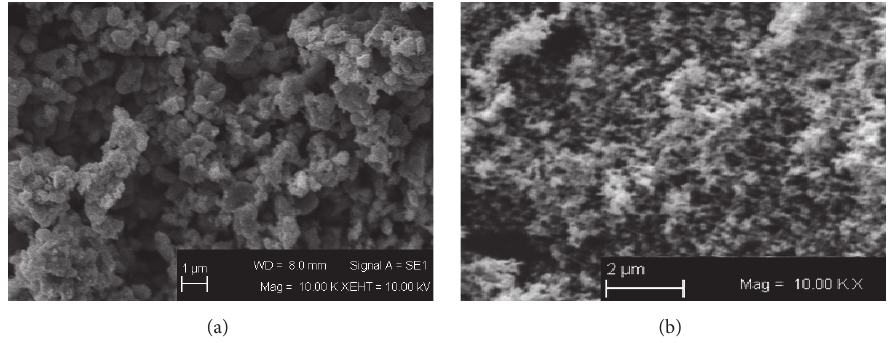
Figure 4: SEM images of (a) ZnO hollow spherical nanostructures and (b) NiO nanoparticles.